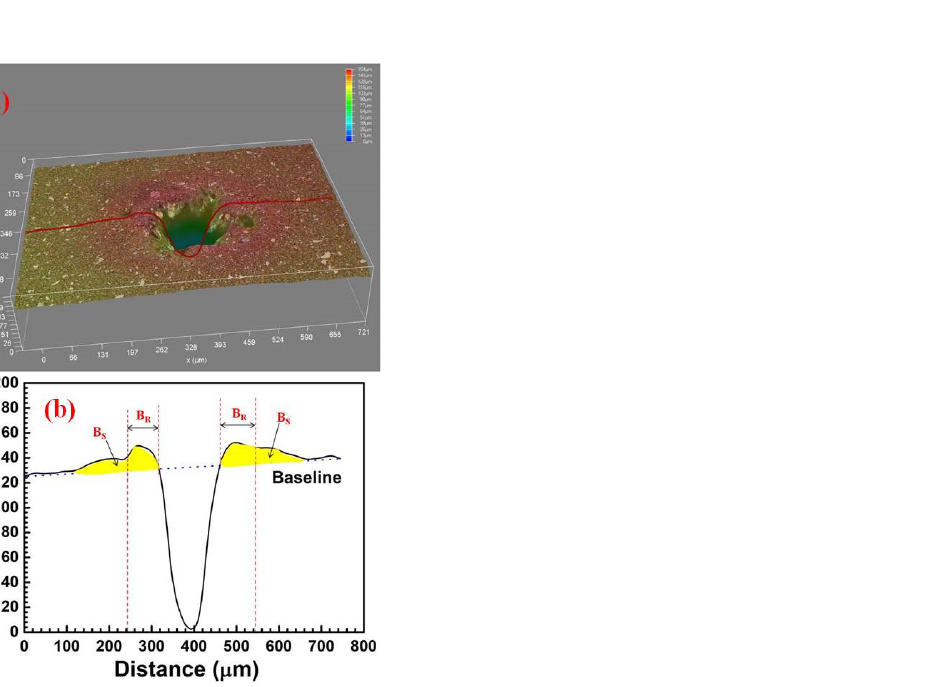
can be seen from the EDS results in Table 3, these oxide particles are all Fe oxides.